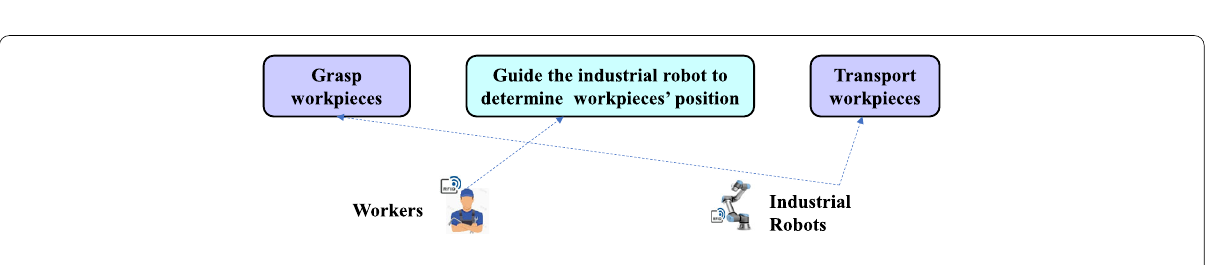
Figure 5 Process of positioning and drilling the workpieces